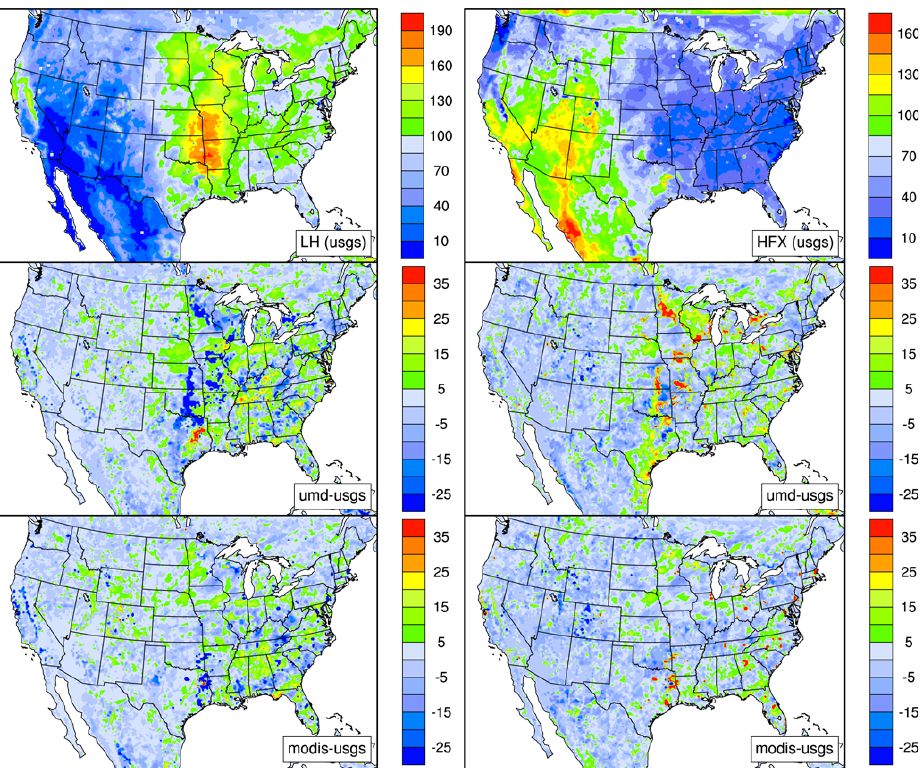
Fig. 4. Same as Fig. 3 except for average latent heat flux (LH, Wm − 2 , left panels) and sensible heat flux (HFX, Wm − 2 , right